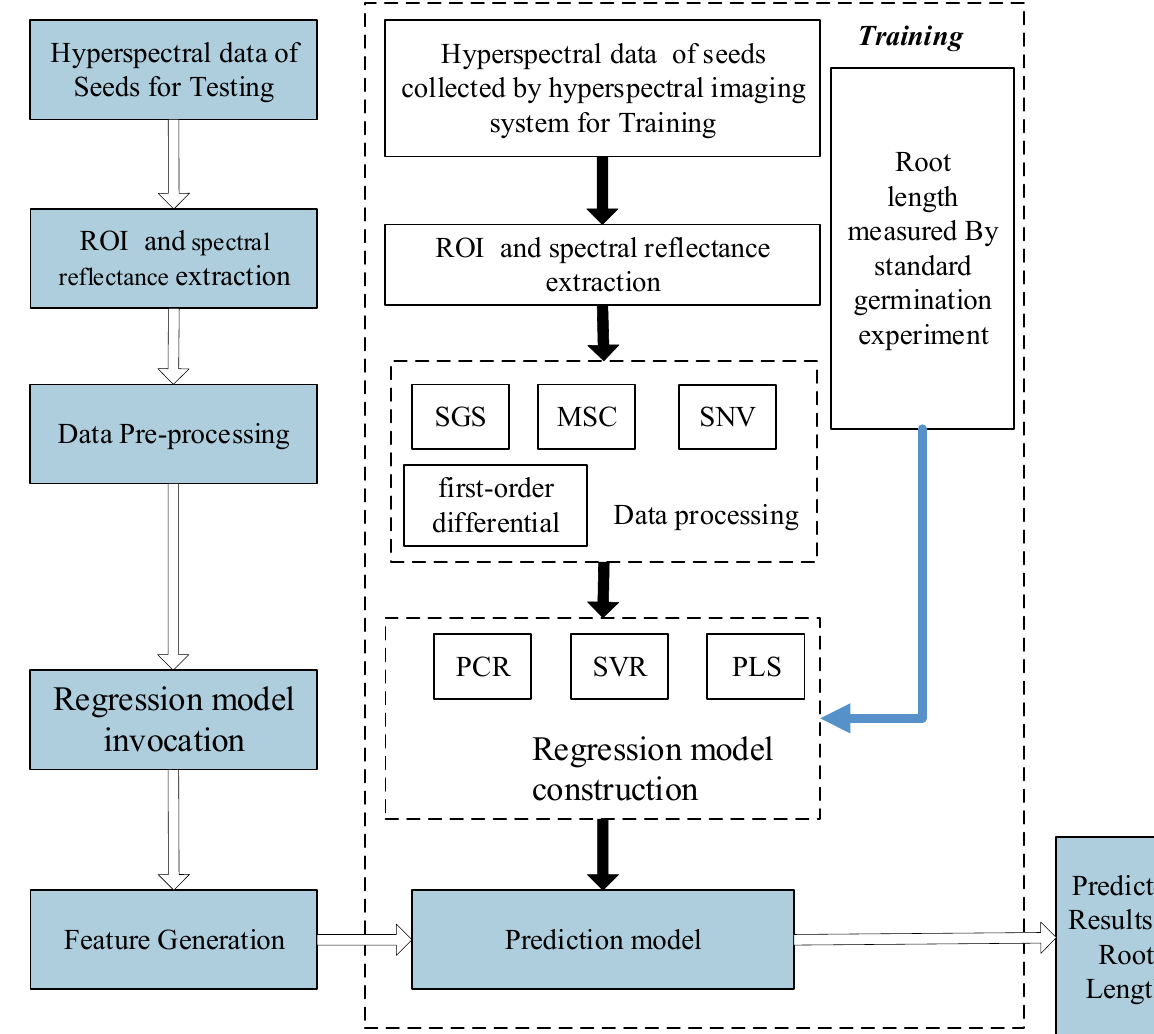
Figure 4. Flowchart of corn seedling root length prediction.